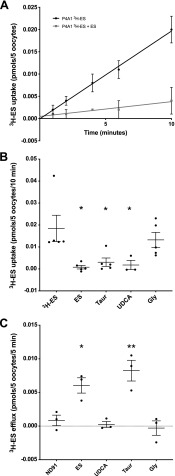
UDCA inhibits OATP4A1 but does not cause transstimulation, suggesting it is not transported. A) 3H-ES uptake into oocytes by OATP4A1 was shown to be linear up to 10 min, and this was inhibited by cold 2.5 mM ES (n = 5 ovaries, 5 oocytes per condition). B) 3H-ES uptake (under sodium-free conditions) in OATP4A1-injected oocytes was inhibited by 500 μM ES, TC, and UDCA (*P < 0.05, n = 5 ovaries, 5 oocytes/condition), but not by negative control glycine. Data are presented as means and sem and are analyzed by a 1-way ANOVA with Dunnett’s post hoc (compared with 3H-ES alone). C) 3H-ES efflux in OATP4A1-injected oocytes is transstimulated by ES (*P < 0.05, n = 3) and TC (**P < 0.01), but not by UDCA or negative control glycine. This suggests that UDCA is not a substrate of OATP4A1. Data are adjusted for background water-injected responses and presented as means and sem. Data were analyzed by a 1-way ANOVA with Dunnett’s post hoc (compared with buffer alone); n > 3 individual ovaries, 5 oocytes per condition for uptake, 15 oocytes/condition for efflux.